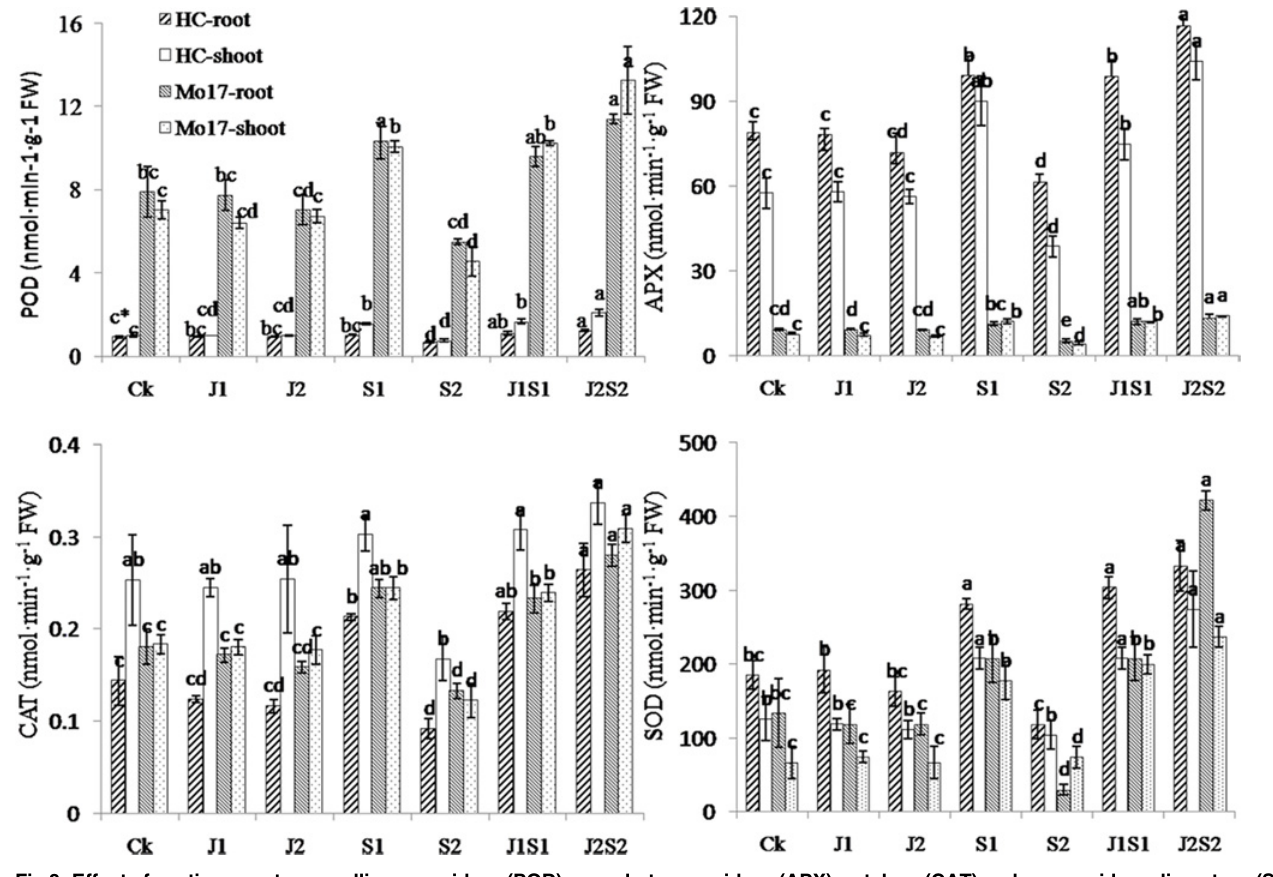
Fig 8. Effect of coating agent on seedling peroxidase (POD), ascorbate peroxidase (APX), catalase (CAT) and superoxidase dismutase (SOD) activities of the maize varieties Huang C (HC) and Mo17 after chilling stress. ( * significant difference (a = 0.05, LSD) among treatments within the same seedling part for the same variety. Error bars represent ± S.E. For additional explanations, see Fig.